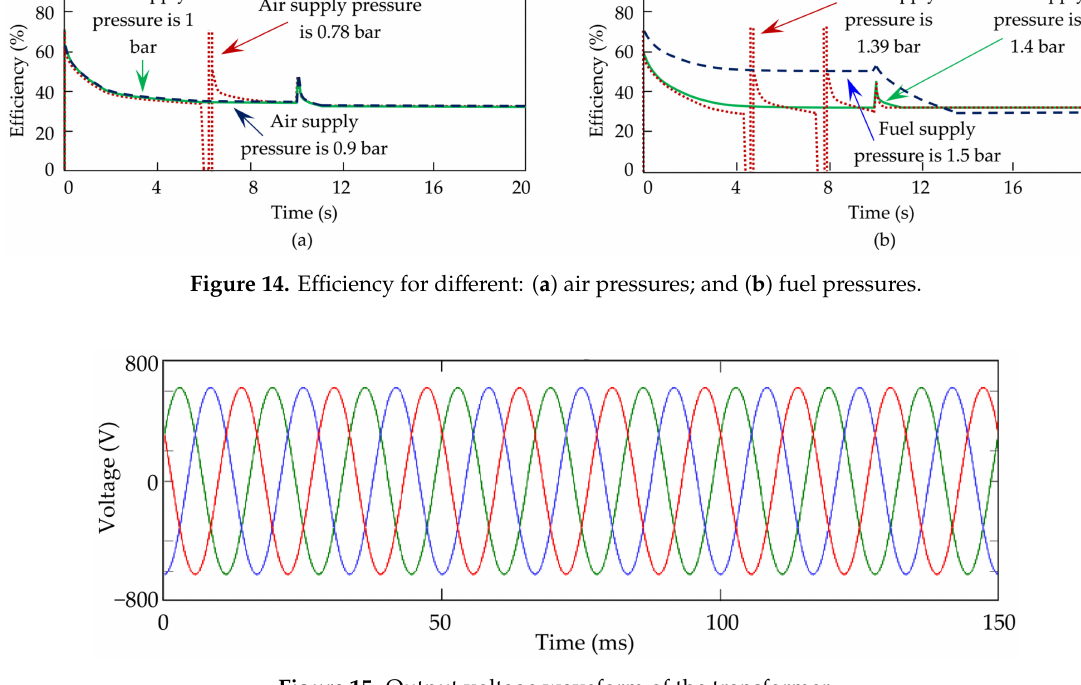
Figure 15. Output voltage waveform of the transformer.